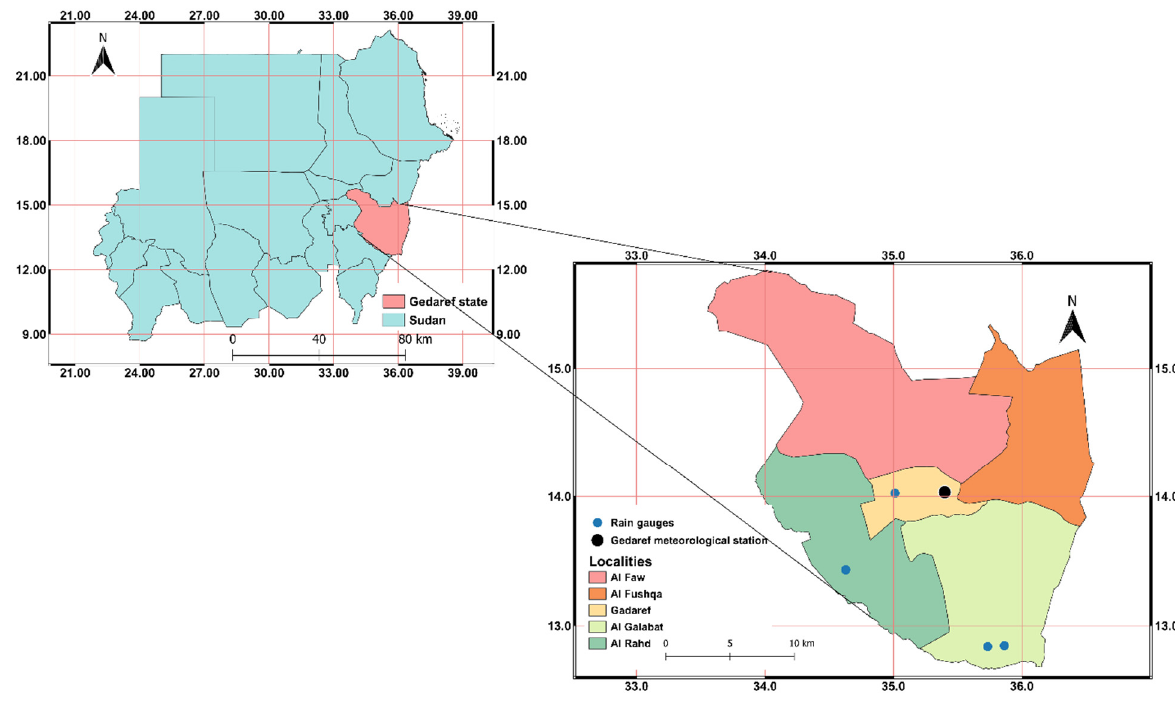
Figure 1. Location of Gedaref state in Sudan.